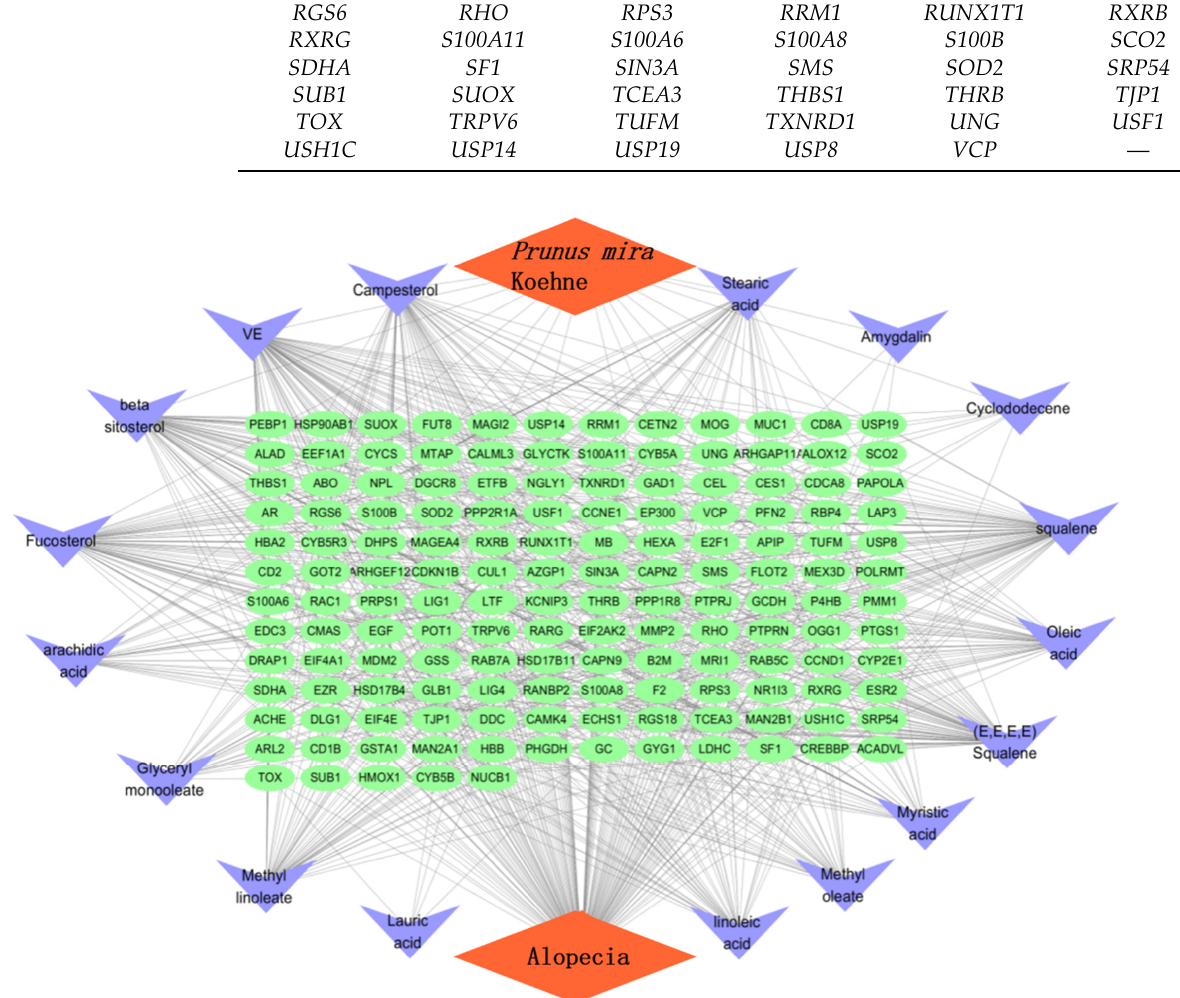
— Figure 3. Venn diagram.